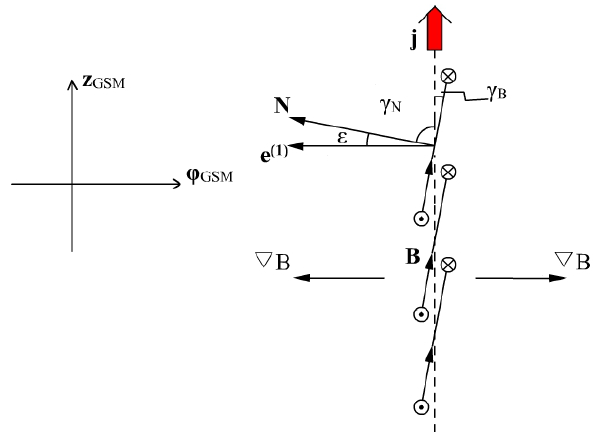
Fig. 4. Schematic illustration of the geometrical structure of the severely tilted current sheet during the Cluster crossing event on 3 August 2004 viewed toward the earth. The dashed line denotes the central plane of the current sheet. The red arrow represents the current density. The directions of the magnetic field in the MFLs have been marked in the figure. Several geometrical parameters of the current sheet are shown. ˆ z GSM and ˆ ϕ GSM are the base vectors along the z axis and azimuthal directions in GSM coordinates, respectively.